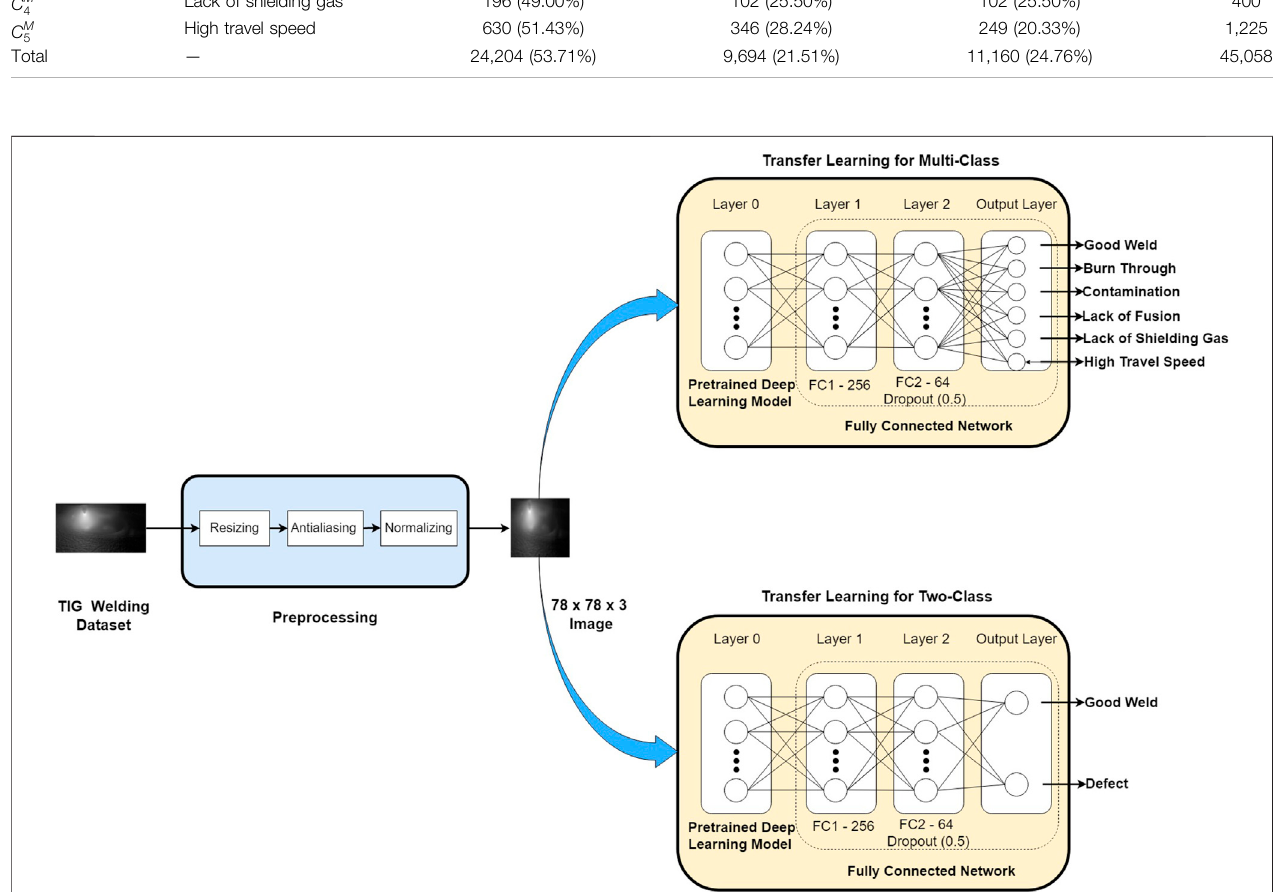
FIGURE 2 | Flowchart of transfer learning methodology for weld defects classi fi cation.